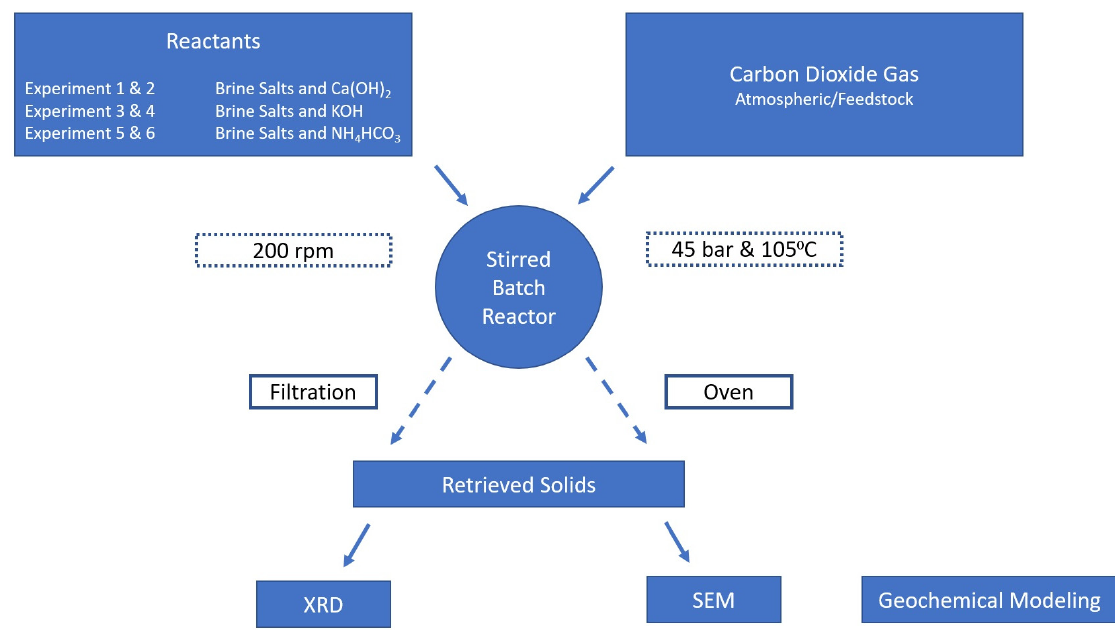
Figure 1. Schematic representation of NaHCO 3 production utilizing brine and CO 2 .